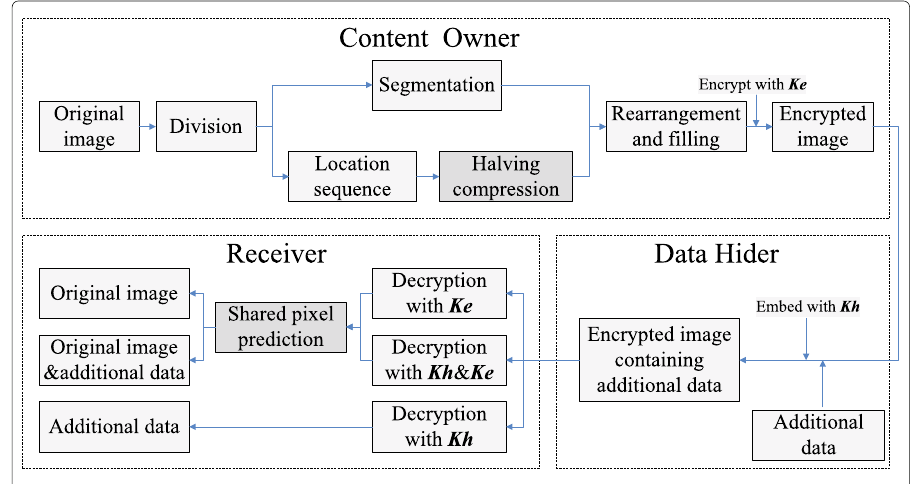
Fig. 1 The framework of the proposed scheme